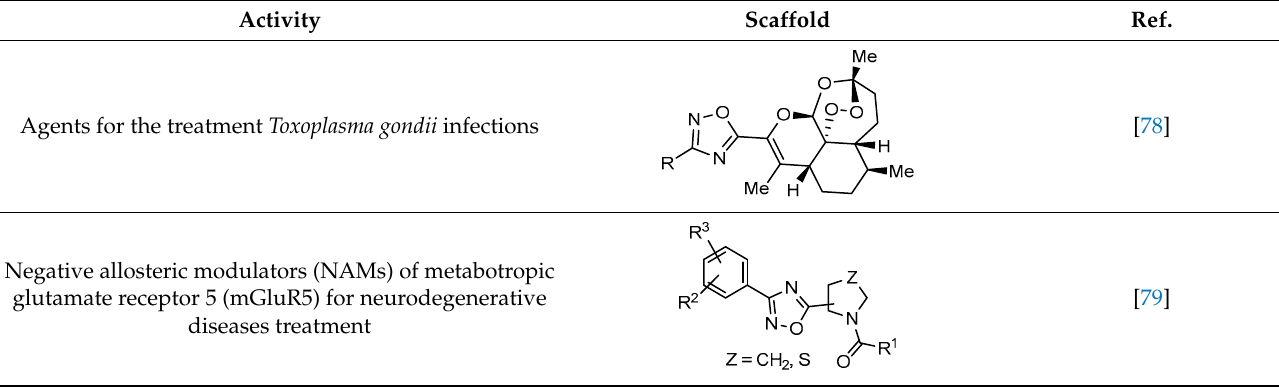
Table 1. Cont. Activity Scaffold